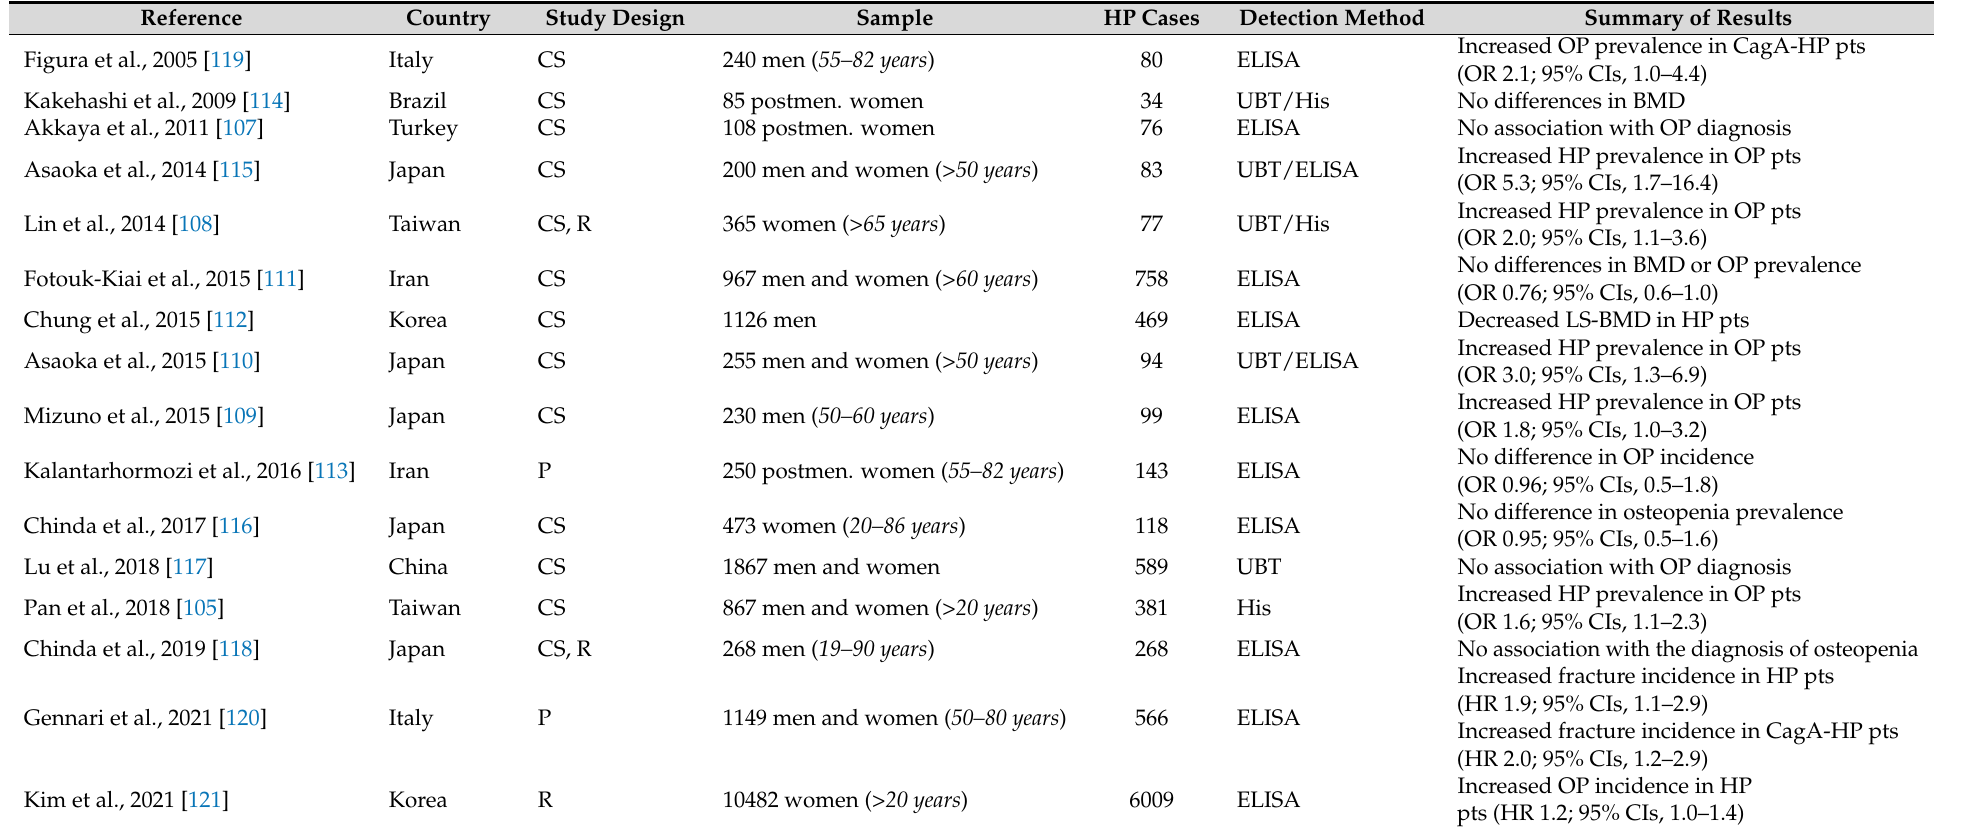
Table 1. Major studies assessing the relationship between Helicobacter Pylori (HP) infection and osteoporosis or